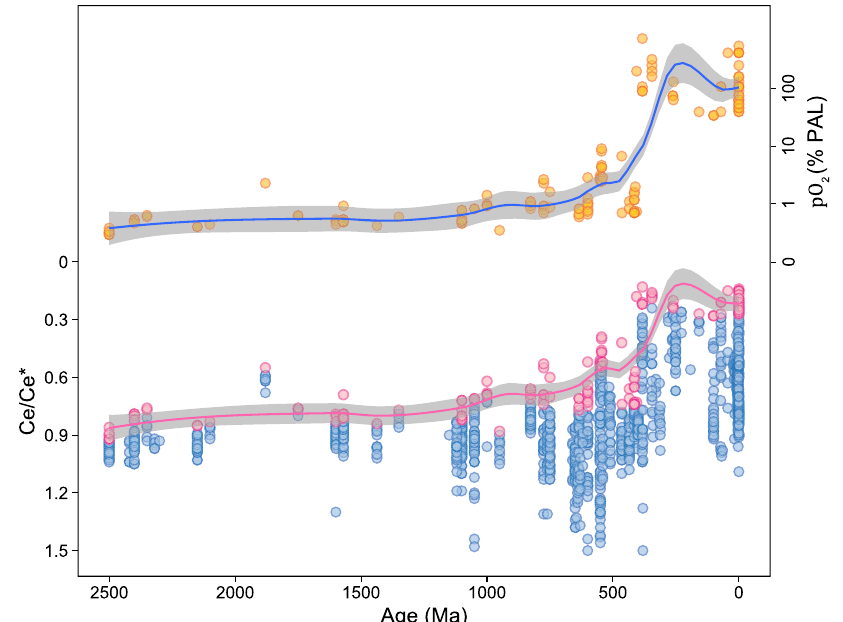
Fig. 2 Estimated partial pressure of atmospheric oxygen and Ce anomaly through Earth ’ s history. Lower part: Secular trend of Ce anomaly (Ce/Ce*) for all complied carbonate data with fi tting to lowest 10% of the data shown in pink circles. The pink line indicates the best fi t for 100 Ma intervals using the Local Polynomial Regression (LOESS) curve fi tting method and the gray fi eld indicates the upper and lower bounds based on 95% con fi dence level. Upper part: Estimated partial pressure of atmospheric oxygen, pO 2 (% PAL), through Earth ’ s history. The blue line shows our best estimate, and the gray fi eld indicates the upper and lower bounds based on 95% con fi dence level using the LOESS curve fi tting method. The pO 2 was calculated using the lowest 10% of all carbonate Ce/Ce* data for 100 Ma intervals.